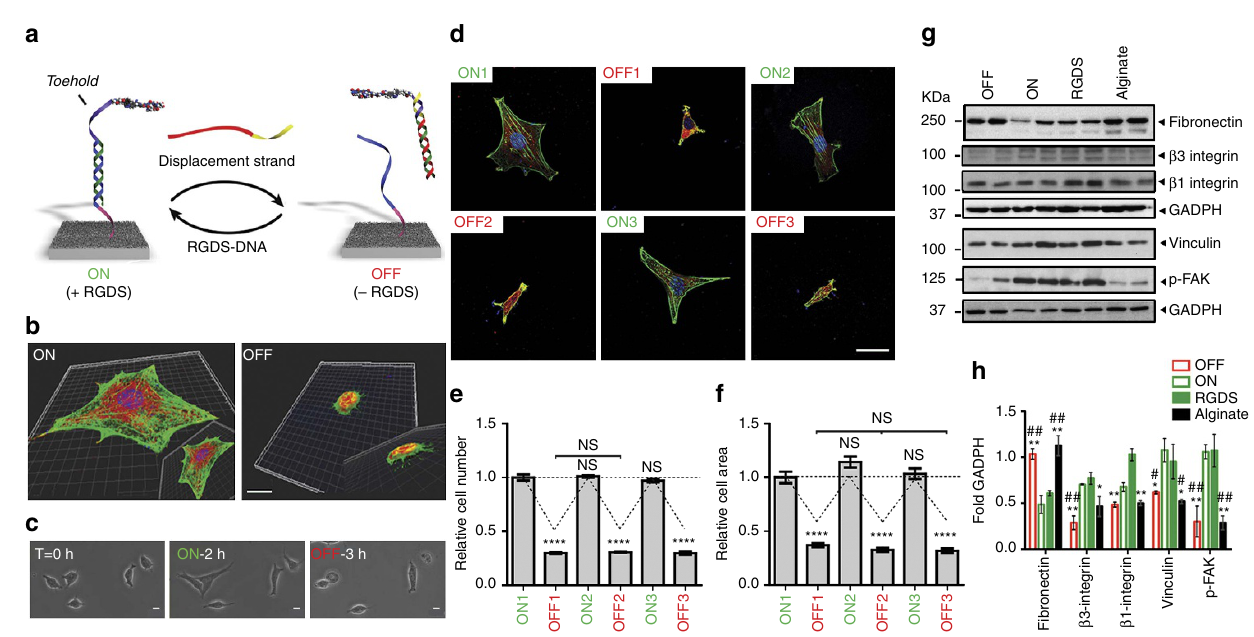
Figure 2 | Dynamic reversible switching of cell bioactivity. ( a ) Schematic representation of toehold-mediated strand displacement system. Engineering a toehold into the bioactive strand allows its removal by a fully complementary displacement strand, thus switching bioactivity OFF; this process regenerates the surface strand, allowing for a second addition of the RGDS-DNA to turn bioactivity back ON. This process can be repeated for multiple cycles. ( b ) Three dimensional shadow projection image of confocal sections of fibroblasts on surfaces where RGDS was displayed (ON state after 2h), and then removed using strand displacement (OFF state after 3h). ( c ) Representative time lapse images of fibroblasts on surfaces in the ON and OFF states (phase contrast). Scale bar: 10 m m. ( d ) Confocal micrographs of cells on surfaces where the bioactivity has been switched ON and OFF for multiple cycles using the toehold mechanism . Staining for actin (phalloidin, green), vinculin (red) and nuclei (DAPI, blue) reveals the cytoskeletal organization, focal adhesions and cell nuclei, respectively. Scale bar: 20 m m ( e ) Normalized cell number and area ( f ) (relative to unmodified alginate; n ¼ 3) for each of the ON–OFF cycles shown in d . ( g ) Western blot analysis of protein expression (related to matrix deposition, integrin activation and stability of focal adhesions) in fibroblasts measured at various ON and OFF states. ( h ) Relative expression of proteins derived from western blots in g . All values were normalized to GAPDH expression, triplicate samples were analysed. (* P o 0.05; ** P o 0.01; **** P o 0.0001; # P o 0.05; ## P o 0.01; * relative to ON1, # relative to